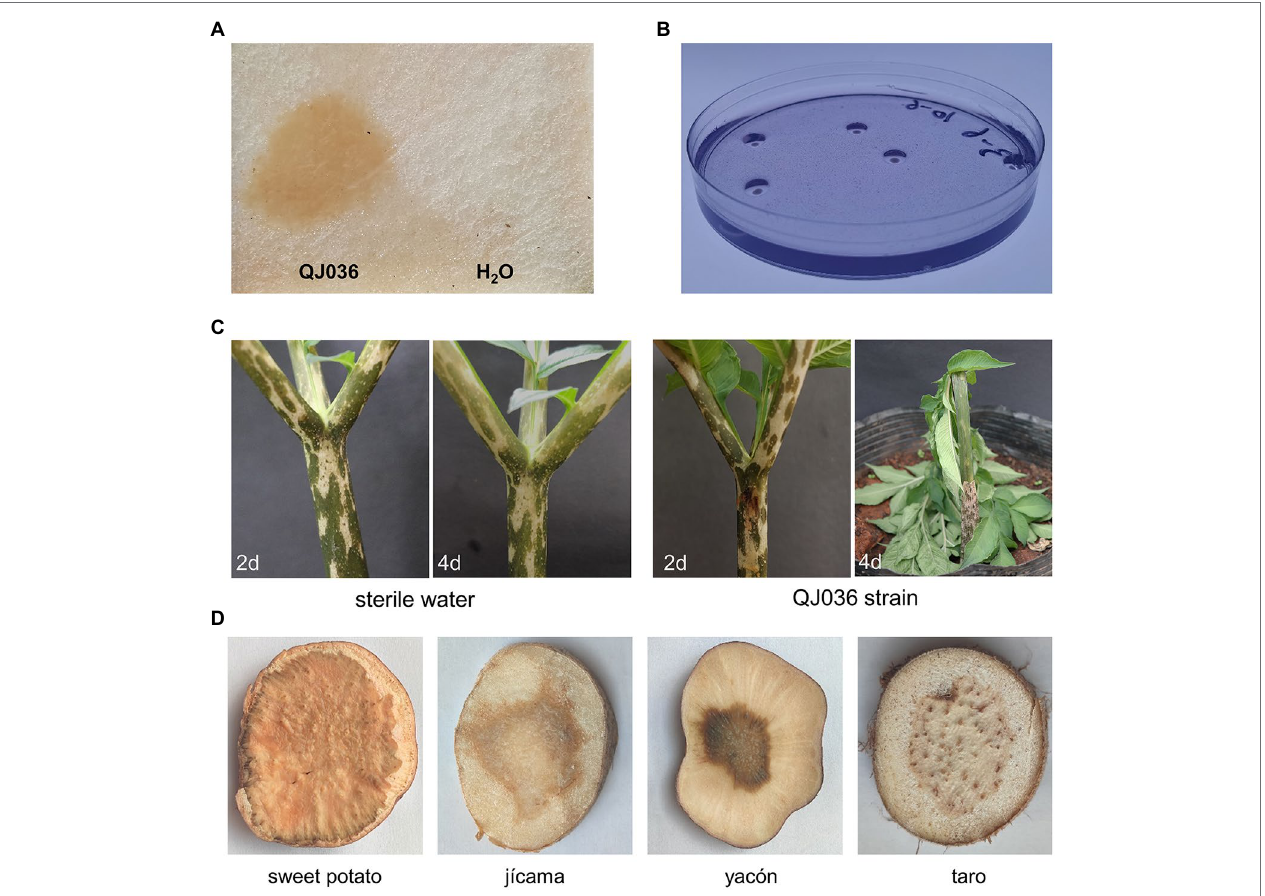
FIGURE 1 | Pathogenicity tests and host range determination of Pectobacterium aroidearum QJ036. (A) Bacterial cultures of QJ036 strain (10 8 CFU/ml) were inoculated on konjac slice tubers for 24 h. Sterile water was also used as negative control. (B) The formation of pits caused by QJ036 strain on CVP medium incubated at 28 ° C for 48 h. (C) Bacterial cultures of QJ036 strain (10 8 CFU/ml) and sterile water were inoculated into stems of 6-months-old konjac seedlings, respectively. Pictures were taken at the indicated time points. (D) Bacterial cultures of QJ036 strain (10 8 CFU/ml) were inoculated on slice tubers of indicated species for 24 h. All these experiments were repeated at least twice independently with similar